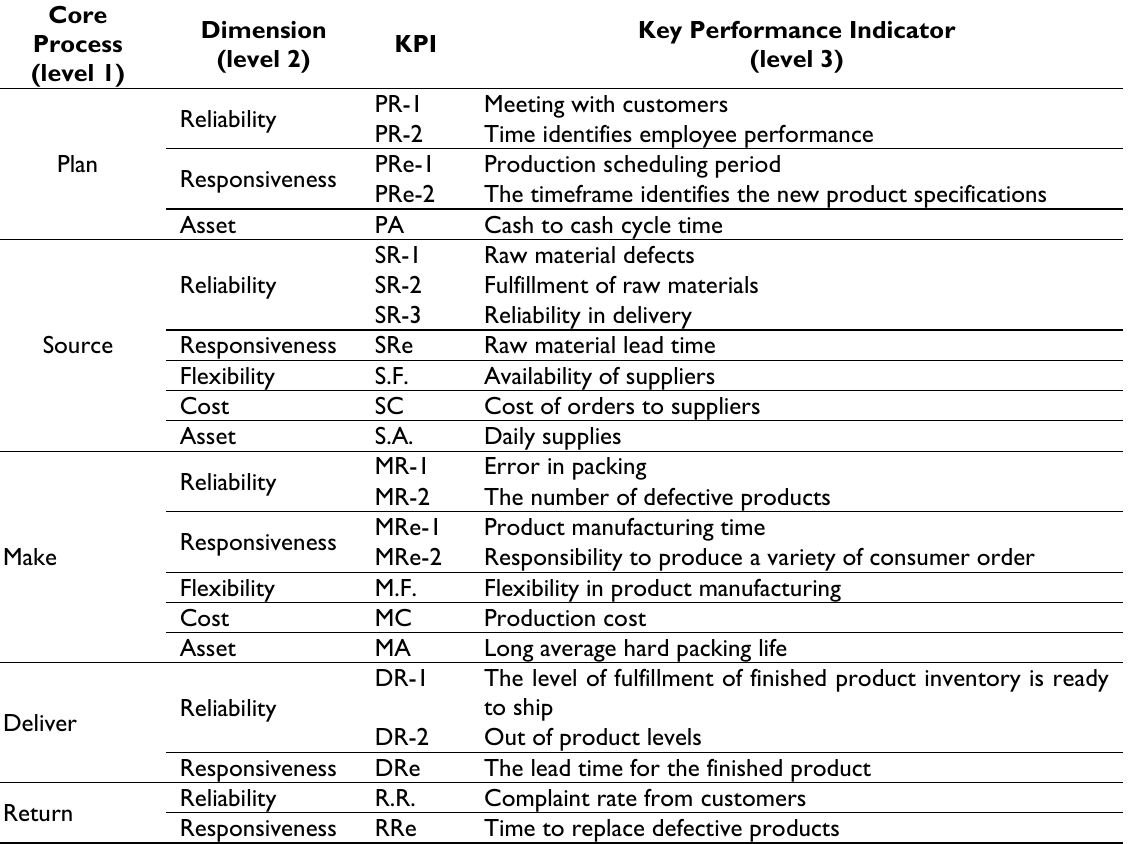
Table 4. Identify Indicators for Each Level in SCM Performance Core Process